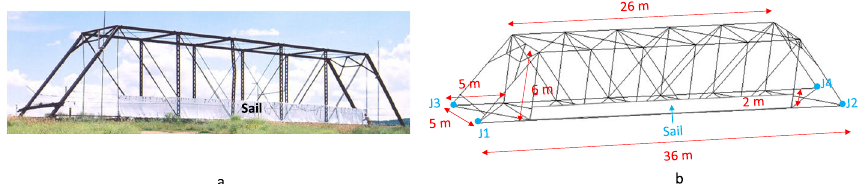
Fig. 1 The Four Mile Bridge in Steamboat Springs, Colorado: a site; b